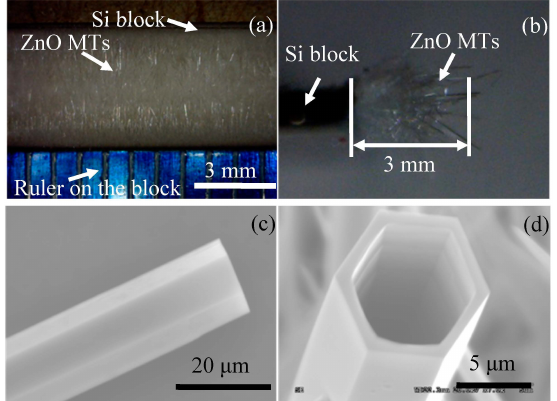
Figure 2. ( a ) Top and ( b ) side views of ZnO MTs grown on the sidewalls of two Si